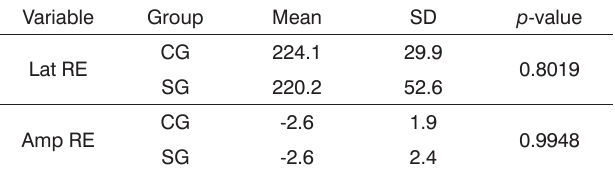
Table 5. Descriptive statistics of the mean, standard deviation (SD) and p -value of the MMNf latency and amplitude variables for the RE.